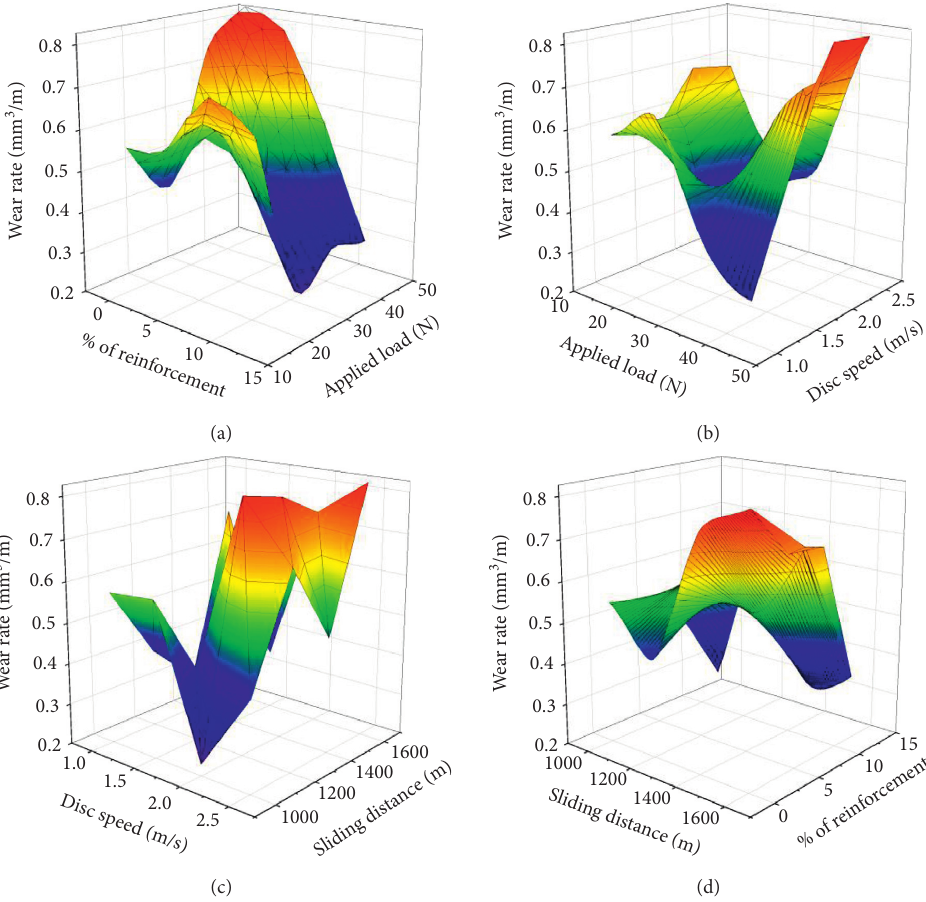
Figure 9: (a) % of reinforcement versus the applied load. (b) Applied load versus the disc speed. (c) Disc speed versus the sliding distance. (d) Sliding distance versus % of